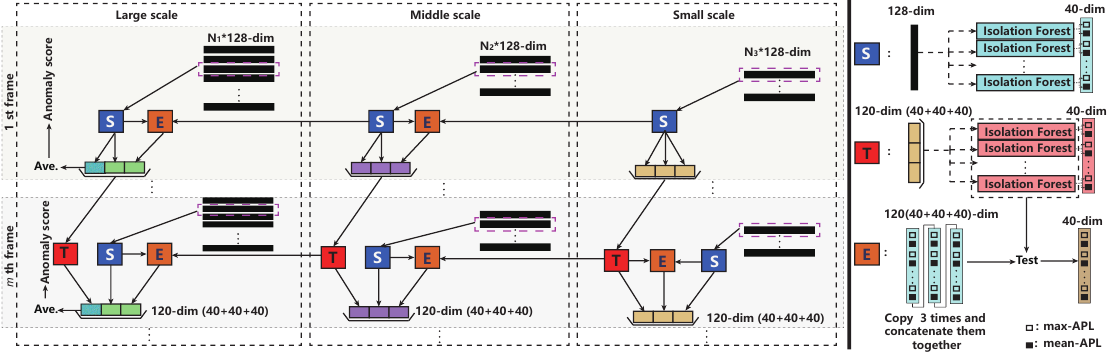
Figure 4. The flowchart of temporal-spatially local anomaly detection, wherein “ T ” represents the temporal iForest ensemble, “ S ” is the spatial iForest ensemble, and “ E ” specifies the module for testing the spatial features (obtained by “ S ” on the current scale) by “ T ” obtained by smaller scale. In the beginning, we only have the S module which detects the abnormal image part with an ensemble of multiple isolation forest in different scales. Then, the “ T ” module (also an ensemble of multiple isolation forest) aims to associate the detected spatial anomaly to subsequent frames, so as to obtain a consistent spatial anomaly results over different frames, and resist the error of optical flow. “ E ” module serves as a bridge over different scales, involving testing the results of “ T ” module from smaller scales by the “ S ” module on the current scale, which wants to leverage the supervision role of smaller scales to the current scale, and make a refined spatial anomaly